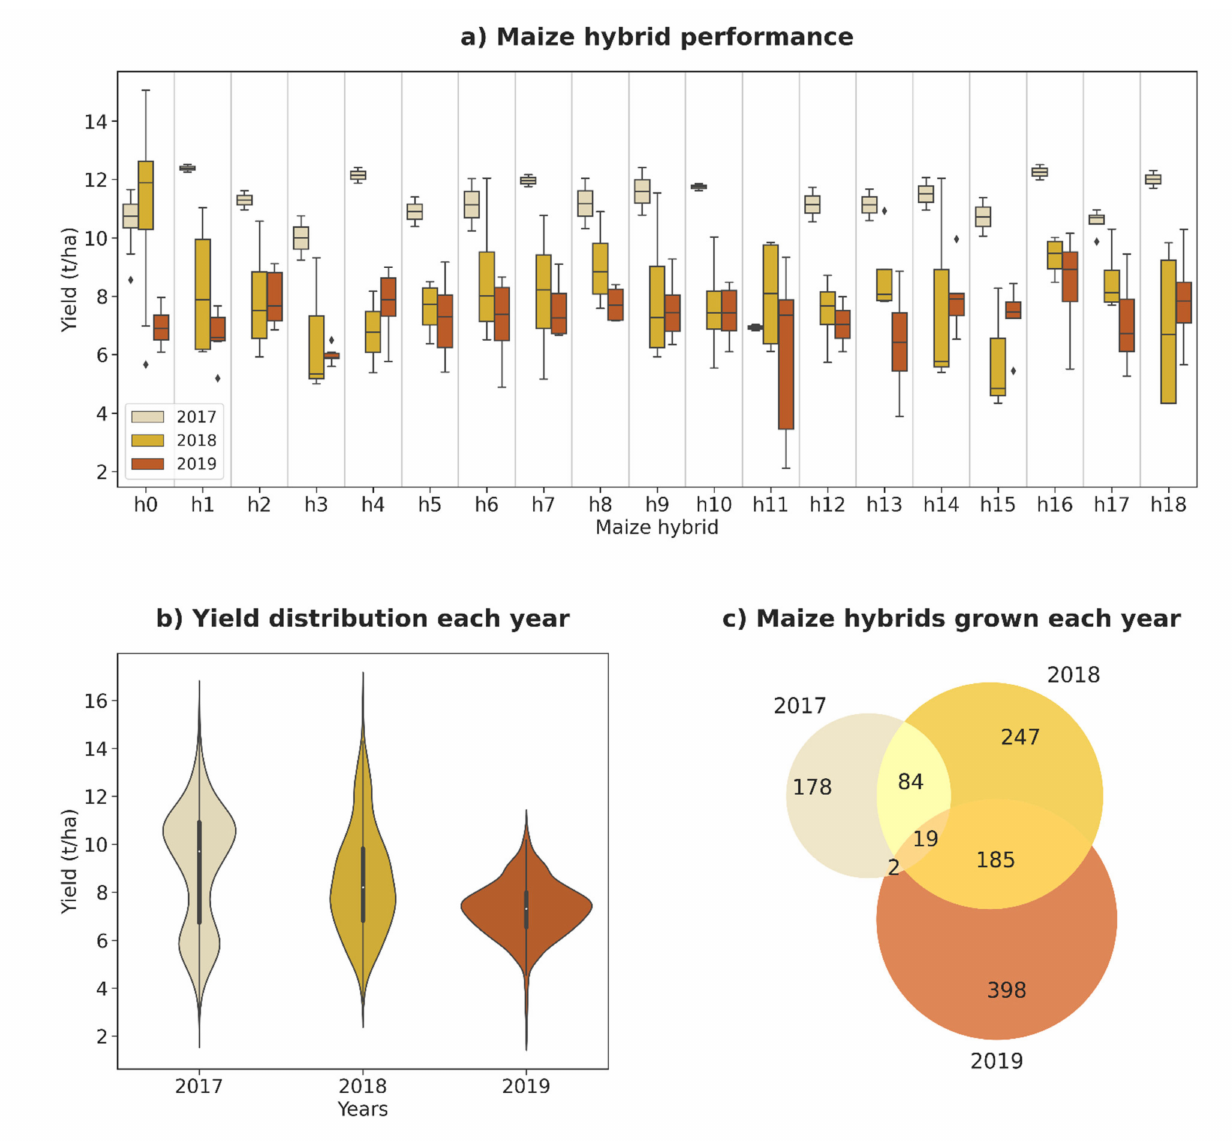
Figure 4. ( a ) Comparison of the yield distribution of the same maize hybrids grown each year of the field trial; ( b ) maize yield distribution per year; ( c ) number of novel and overlapping maize lines grown each